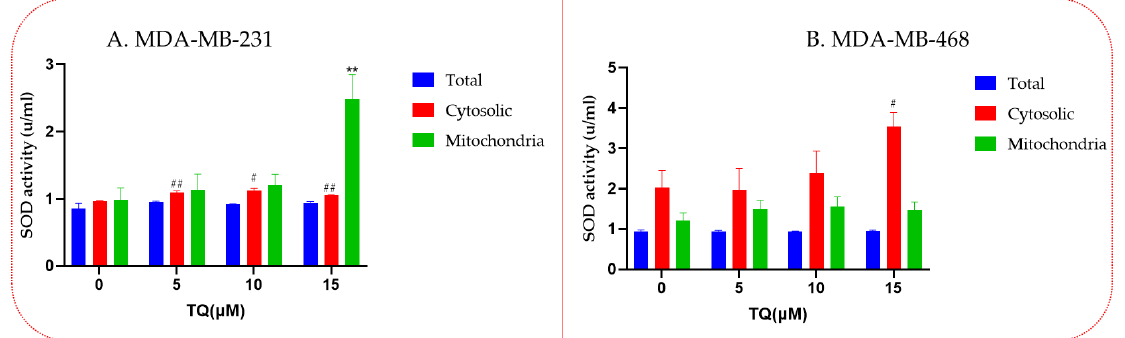
Figure 5. TQ effect on SOD enzyme activity in TNBC cells. In this assay, 1.5 × 10 6 cells/well/6-well plates were incubated overnight before treatment. The next day, cells were treated for 24 h with different concentrations of TQ. SOD activity was displayed on MDA-MB-231 cells ( A ) and MDA- MB-468 cells ( B ). Asterisks show that SOD activity has significantly increased when compared to controls. Each bar indicates the mean ± SEM of three replications using one-way ANOVA. The in- creased levels were considered statistically significant at ** p < 0.01, # p < 0.05, ## p < 0.01, and ns nonsignificant when comparing control vs. treated, (*) refers to the significant increase in SOD ac- tivity in the mitochondria, whereas # refers to the significant increase in SOD activity in the cytosol.